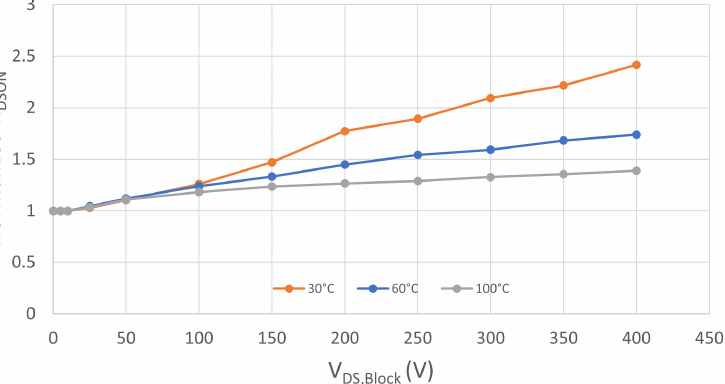
Figure 13. Normalized R DS , ON vs. V block of sample M2 for three temperatures: 30 ◦ C, 60 ◦ C, and 100 ◦ C.